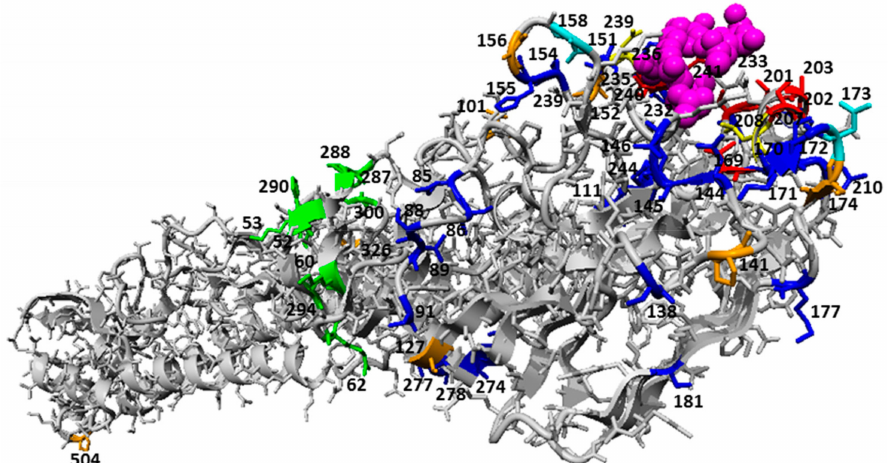
Figure 3. Pairs of sites with significantly di ff erent association between passages after Bonferroni correction mapped to HA monomeric structure (PDB 3UBN) in context of common passage bias sites. Structural positions of dominant passage bias sites and sites undergoing epistatic interactions that are under the influence of passage bias adaptations are highlighted in the Figure. The ligands (sialic acid and N -acetyl glucosamine) are shown in pink ball representation. Epistatic sites are highlighted in orange. Passage bias sites (with high geometric mean of odds ratio across subtype and cell combinations) in the receptor binding region are colored in red and sites 208 and 239 which overlap with epistatic sites are colored in yellow (i). The rest of the passage bias site in the globular head region are colored in blue. Sites 158 and 173 which overlap with epistatic sites are highlighted in cyan. Sites colored in green lie at a region undergoing pH dependent structural changes during fusion (ii). A third identified passage region is not shown as it is in the unstructured signal peptide region (iii).